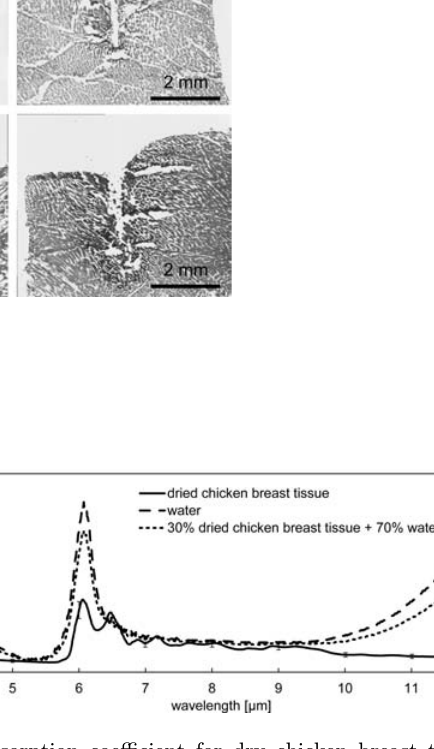
Fig. 8. Absorption coe±cient for dry chicken breast tissue, water and 30% dried chicken breast tissue þ 70%